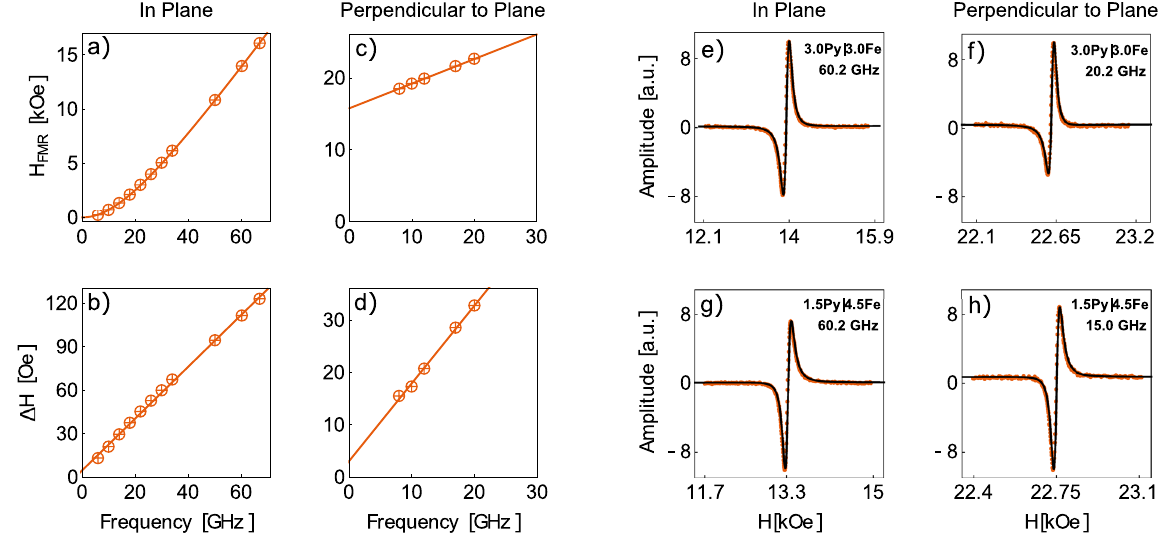
Figure 3. Examples of FMR data for in-plane and perpendicular-to-plane measurements of Py ( 3 )| Fe ( 3 ) sample. The resonance fields, H FMR , and the resonance peak broadening, Δ H , as a function of frequency for ( a , b ), in-plane, and ( c , d ), perpendicular-to-plane external field configurations. FMR spectra of ( e ) Py ( 3 )| Fe ( 3 ) in-plane at 20.2 GHz, ( f ) Py ( 3 )| Fe ( 3 ) perpendicular-to-plane at 60.2 GHz, ( g ) Py ( 1 . 5 )| Fe ( 4 . 5 ) in-plane at 15 GHz, and ( h ) Py ( 1 . 5 )| Fe ( 4 . 5 ) perpendicular-to-plane at 60.2 GHz. The solid line is a perfect fit to the signal by assuming an admixture of the out-of-phase and in-phase components of RF susceptibility 21 , this is a common procedure for measurements on transmission line and terminated